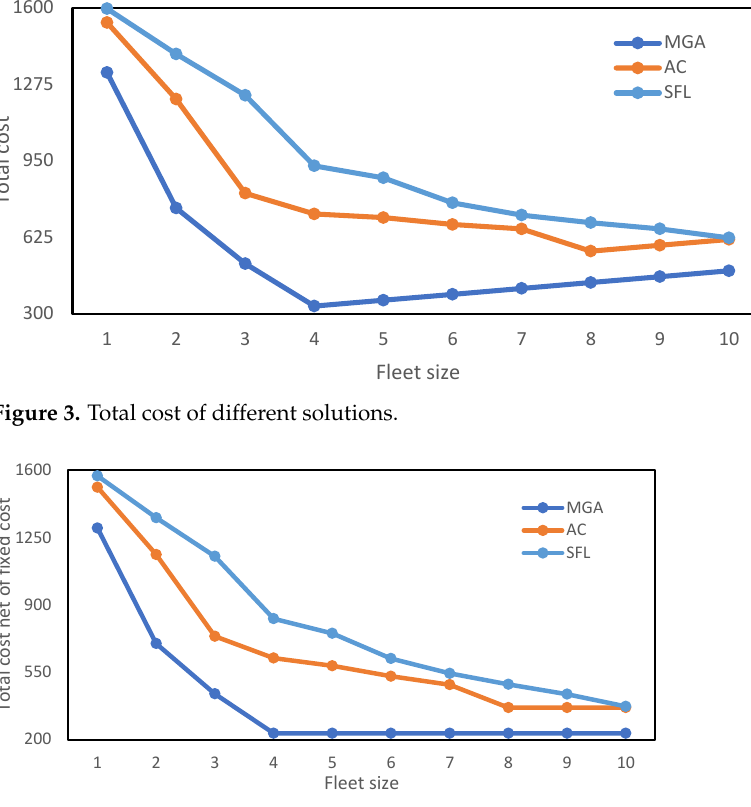
Figure 4. Total cost (net of fixed cost) of different solutions.